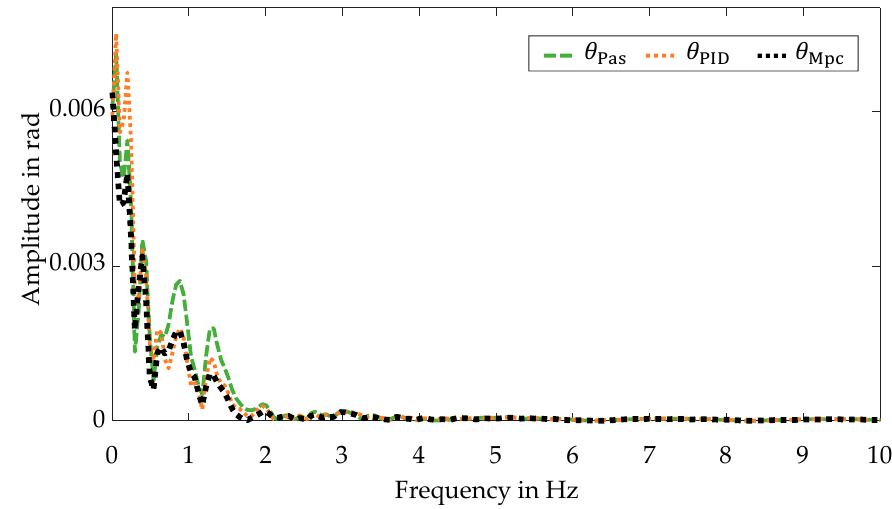
Figure 8. Control Quality Double Lane Change–Pitch Behavior-Frequency Spectra.